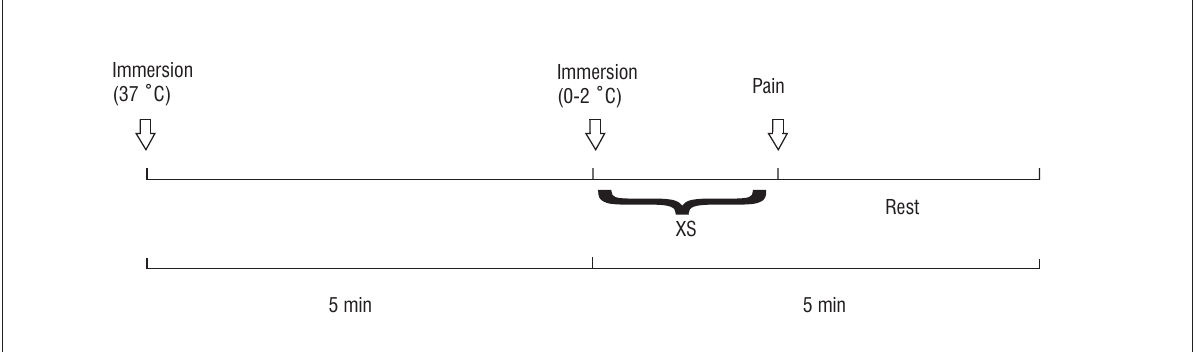
Figure 2 - Detailing of each experimental cycle Source: Johnson and Tabasam